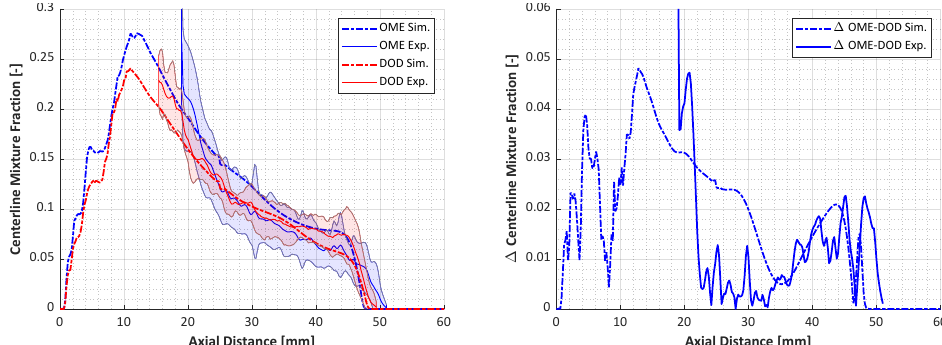
Figure 8. SprayA3 ( Ai ) @ t aSOI = 1000 µ s : ( left ) Mixture fraction in centerline of spray axis. ( right ) Difference of centerline mixture fraction between fuels. The fuel specific differences in the centerline mixing field are characterized within the right plot of Figure 8. The simulations show a greater change in mixture fraction than